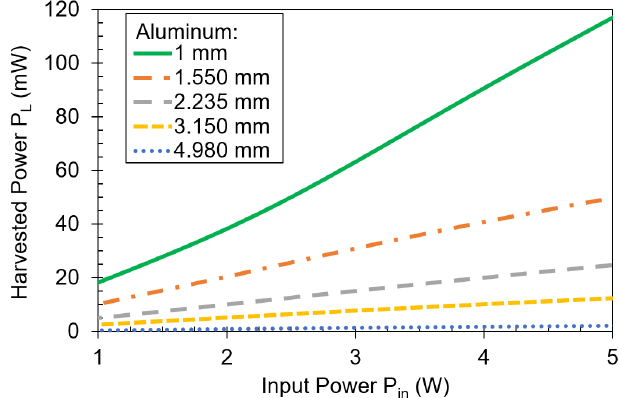
Figure 13. Harvested power versus input power using aluminum plates of different thickness. The frequency is 2 kHz.